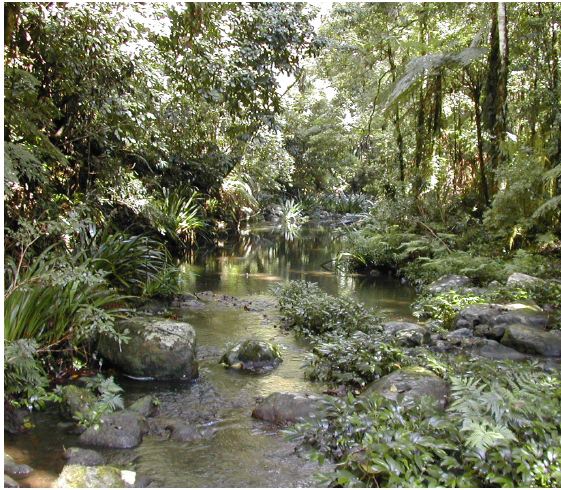
Image 2. Natural habitat of Euastacus sulcatus (03.ii.2002, © Jason Coughran, Brindle